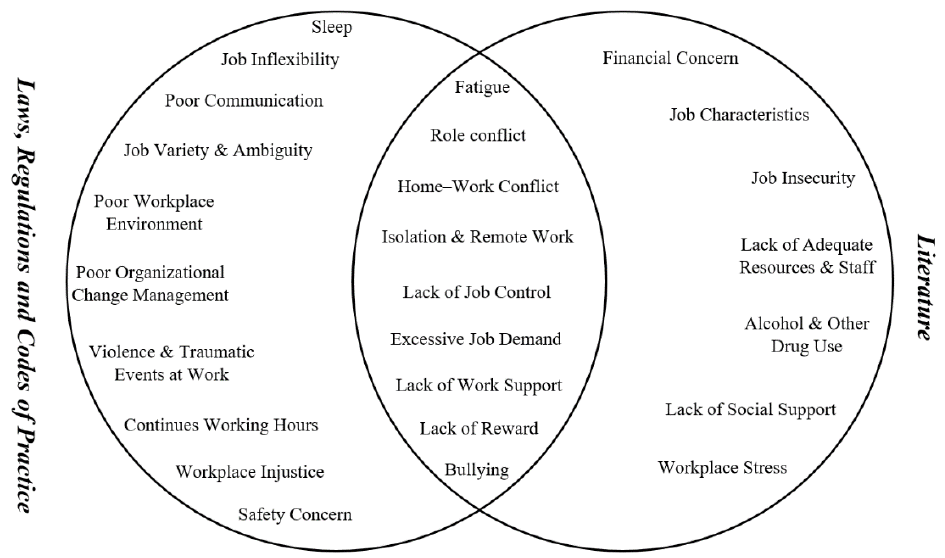
Figure 3. Convergence (LOS > 0.60, F lit > 0.20, F cop > 0.20) and divergence between the retrieved literature and the selected laws, regulations, and codes of practice towards mental health risk factors.